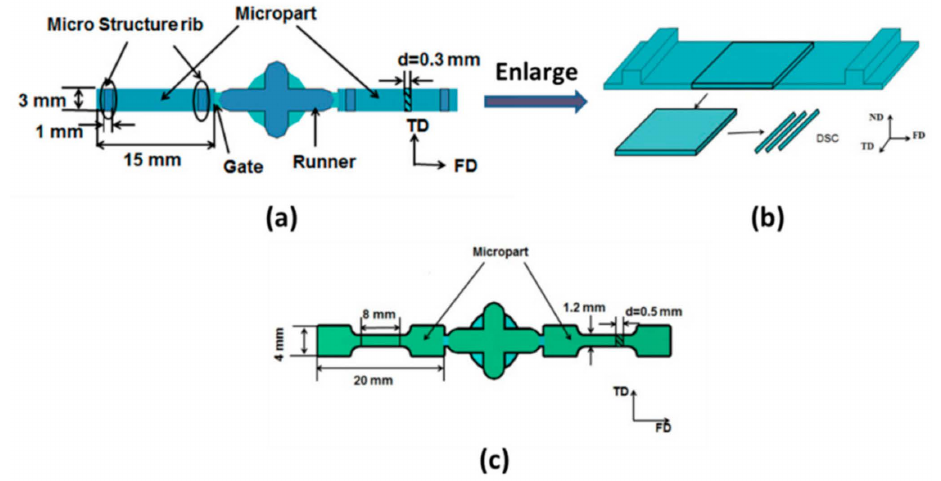
Figure 1. Dimensions of the micro-part ( a , b ) and the dumbbell-shaped micro-part ( c